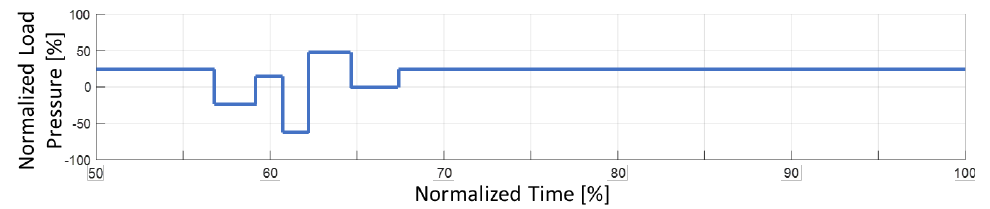
Figure 18. Conceptual Drive Cycle of Vehicle Load at 50 – 100% of the Time.